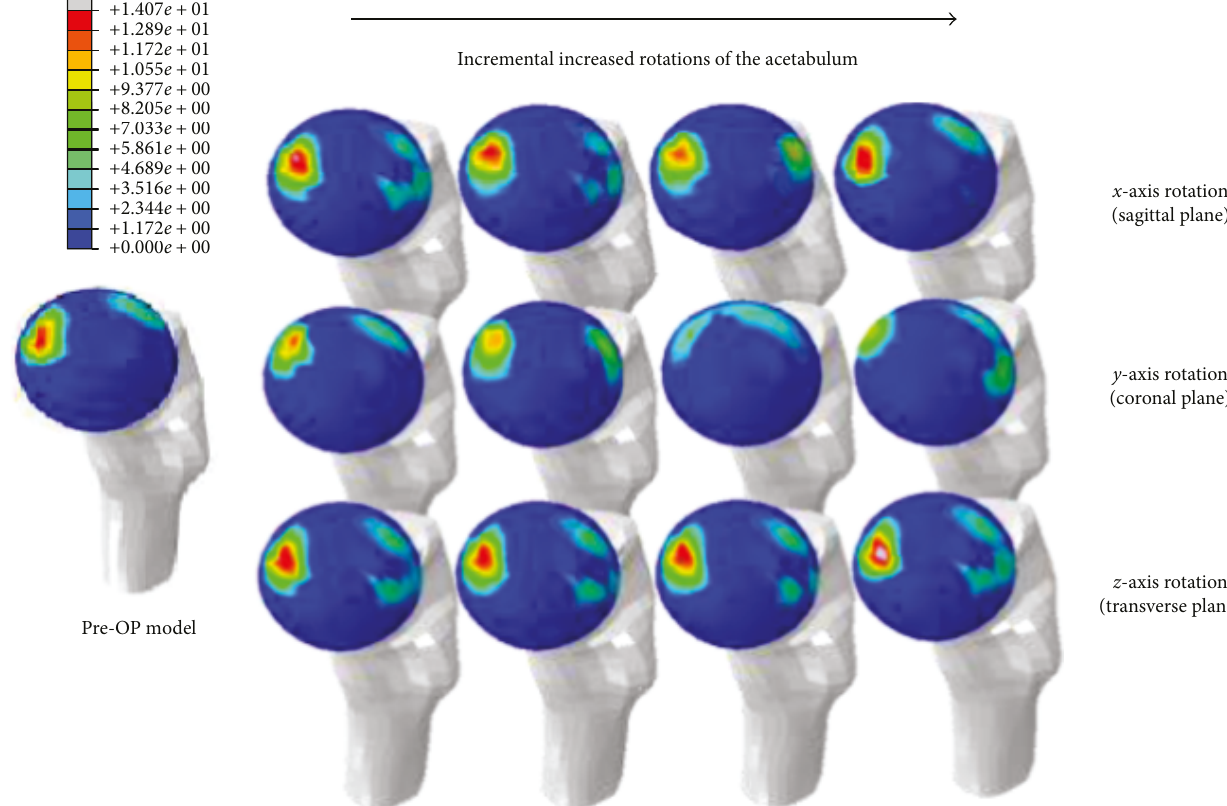
Figure 8: Contact pressure distributions of the Pre-OP model and twelve Post-OP models due to rotations of the osteotomized acetabulum in three anatomical